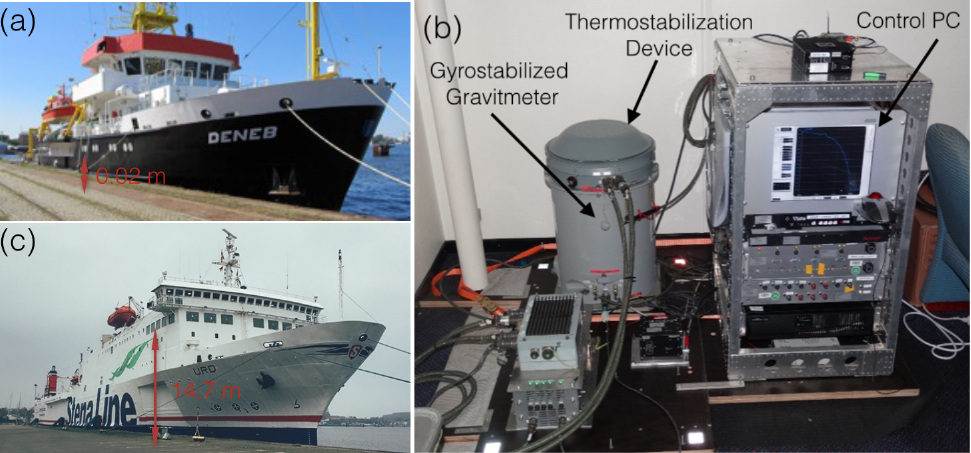
Figure 2. ( a ) The research vessel DENEB. ( b ) The mobile air-marine gravimeter Chekan-AM. ( c ) The ferry